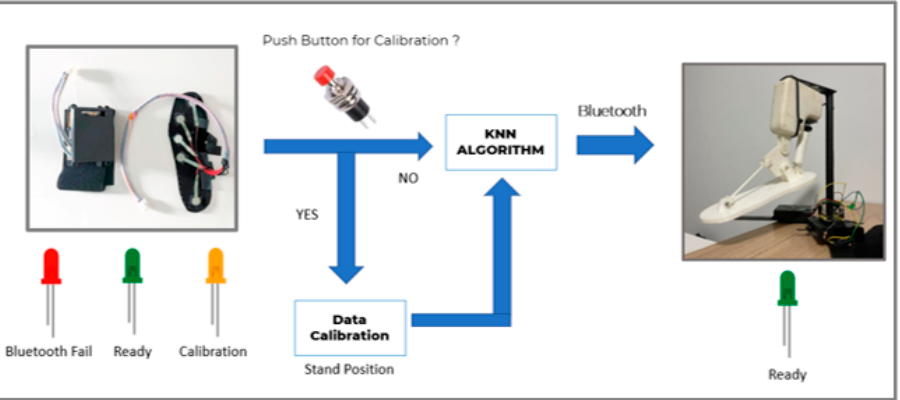
Figure 5. The schematic of the gait analysis with the calibration system for controlling the transtibial prosthetic.